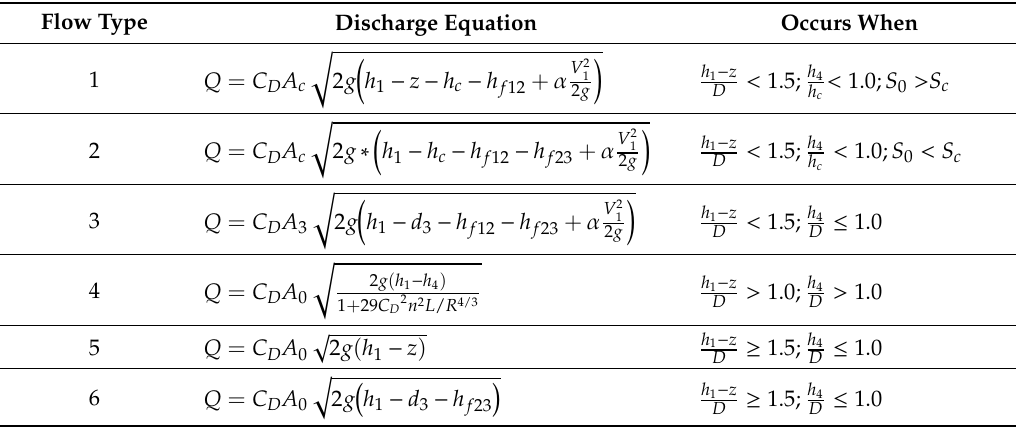
Table 1. Summary of the di ff erent flow types through a culvert by Bodhaine [46], how to calculate the discharge, and when to use which